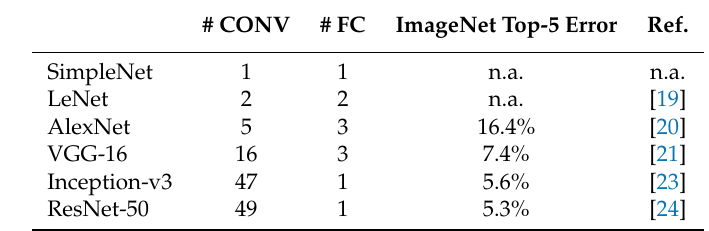
Table 2. Full training: CNN models. Each row of the table reports: name, number of Convolutional (CONV) and Fully-Connected (FC) blocks, and, where available, the top-5 % error on the ImageNet dataset, as well as the reference